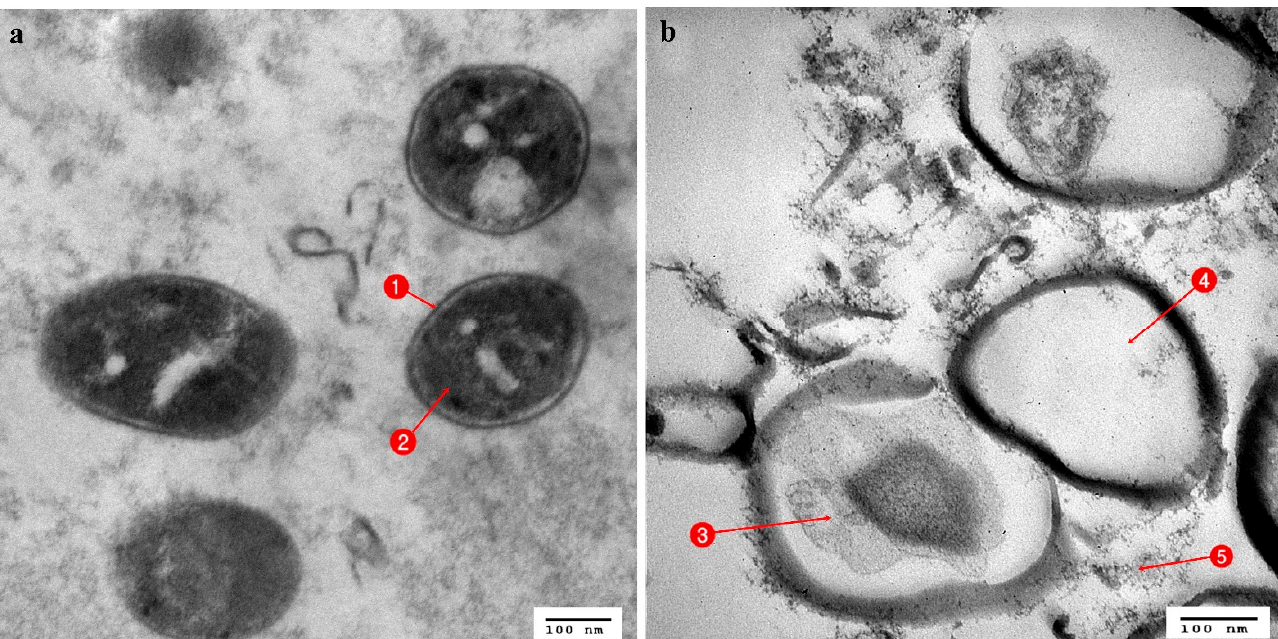
Figure 6. TEM micrograph of MRSA; ( a ) Normal cells: 1. Cell wall; 2. Cytoplasm; ( b ) cell affected with Serratia marcesens : 3. Shrinkage of cytoplasm; 4. Empty cell; 5. Leakage of cell material.